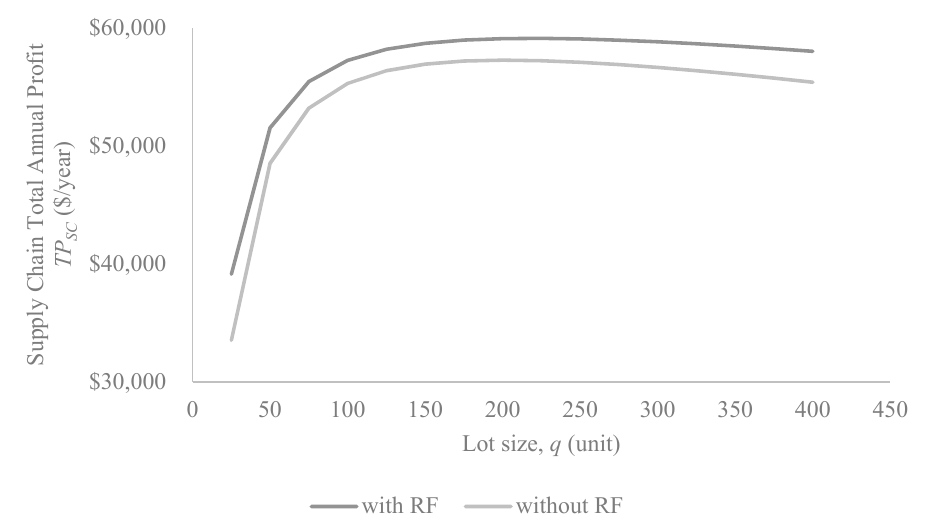
Figure 6. Supply chain total annual profit as a function of the lot size for the cases with and without a reverse factoring agreement.